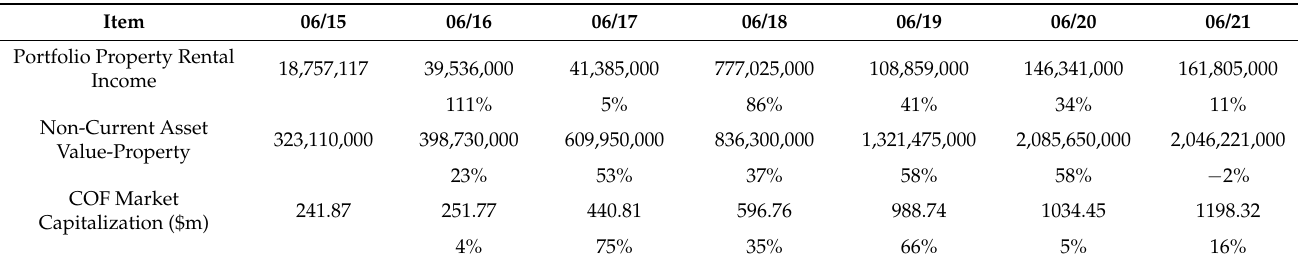
Table 3. Preliminary COF Performance